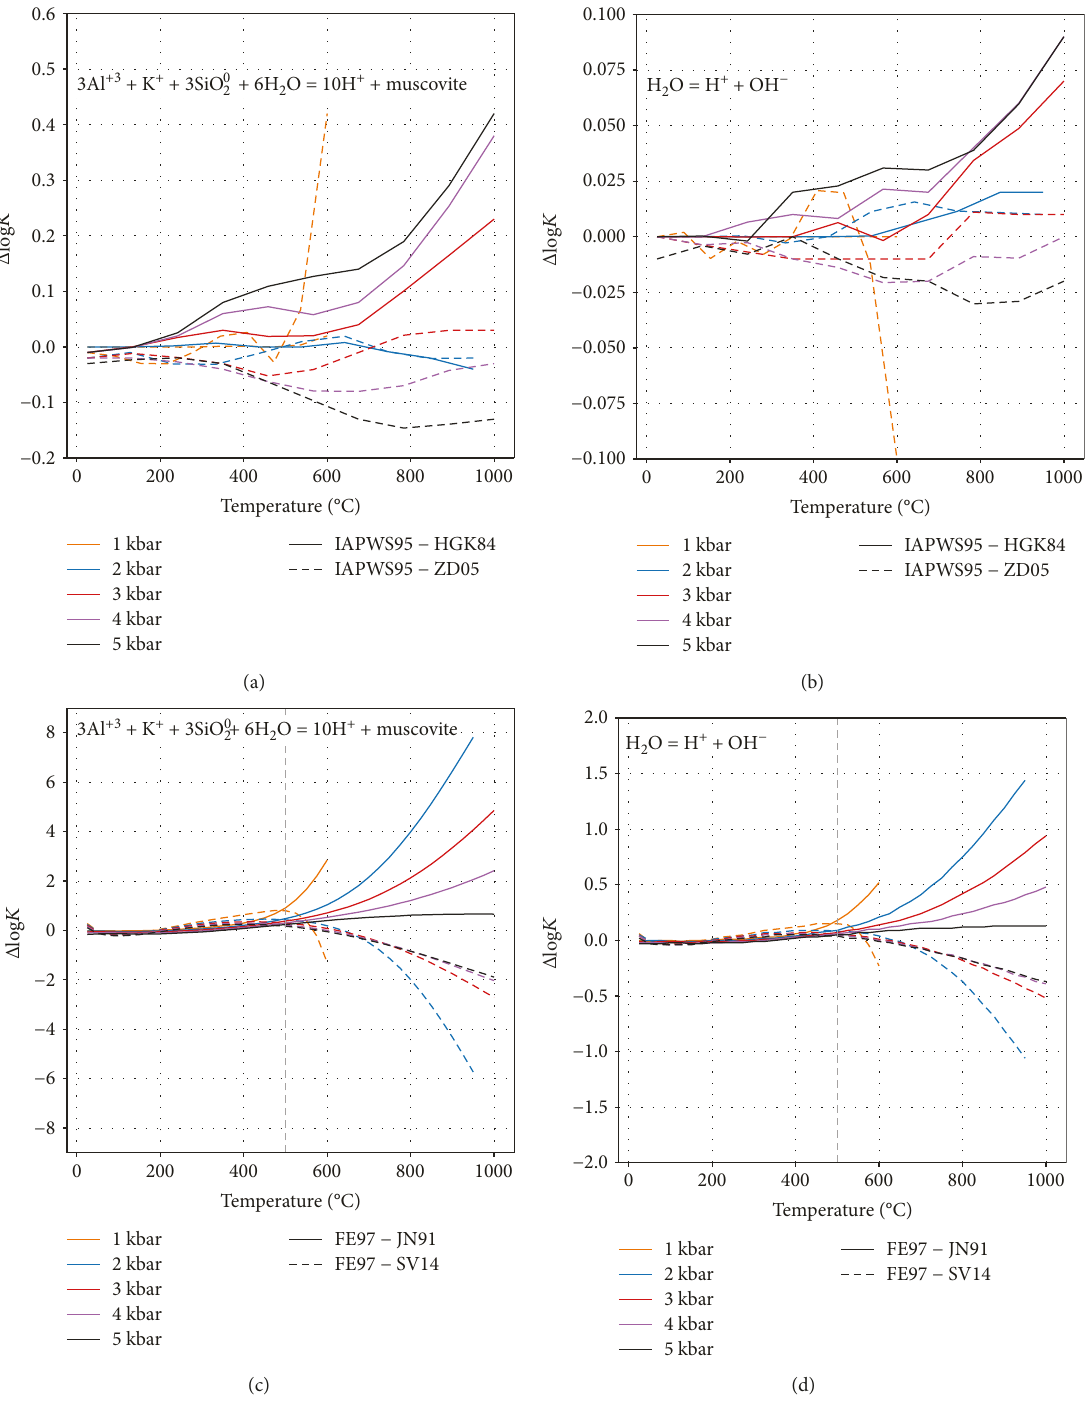
Figure 6: Di ff erences in log K values of muscovite precipitation and water dissociation reactions, obtained from di ff erent thermodynamic models: (a and b) full lines — di ff erence between IAPWS95 and HGK84, and dashed lines — between IAPWS95 and ZD05 models for calculating water volumetric properties, using FE97 for water dielectric properties; (c and d) full lines — di ff erence between FE97 and JN91, and dashed lines — between FE97 and SV14 models for calculating water dielectric properties, using IAPWS95 for water volumetric properties. A vertical dashed line at 500 ° C is shown on (c and